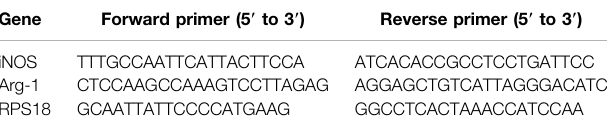
TABLE 1 | Primer sequences used for quantitative real-time